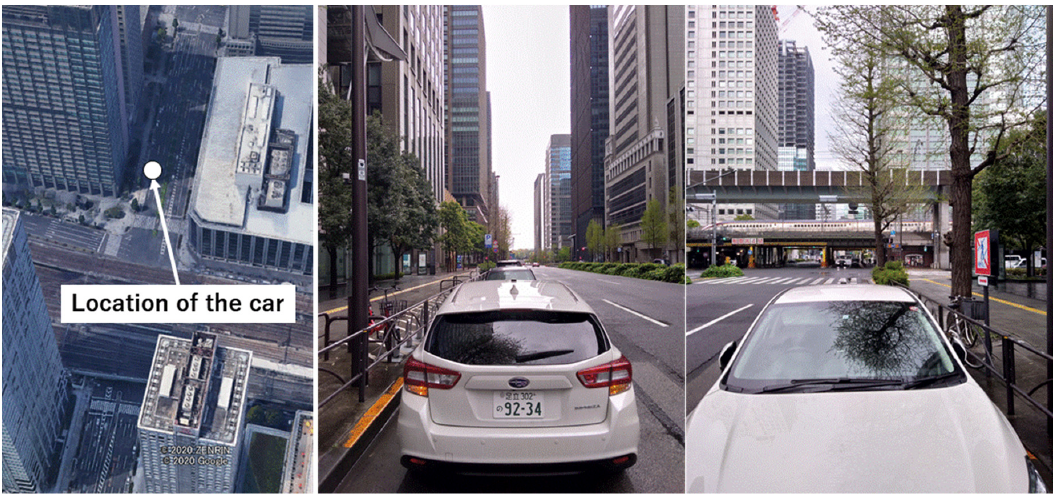
Figure 16. Location of car and detailed images around antenna. Sensors 2018 , 18 , x FOR PEER REVIEW